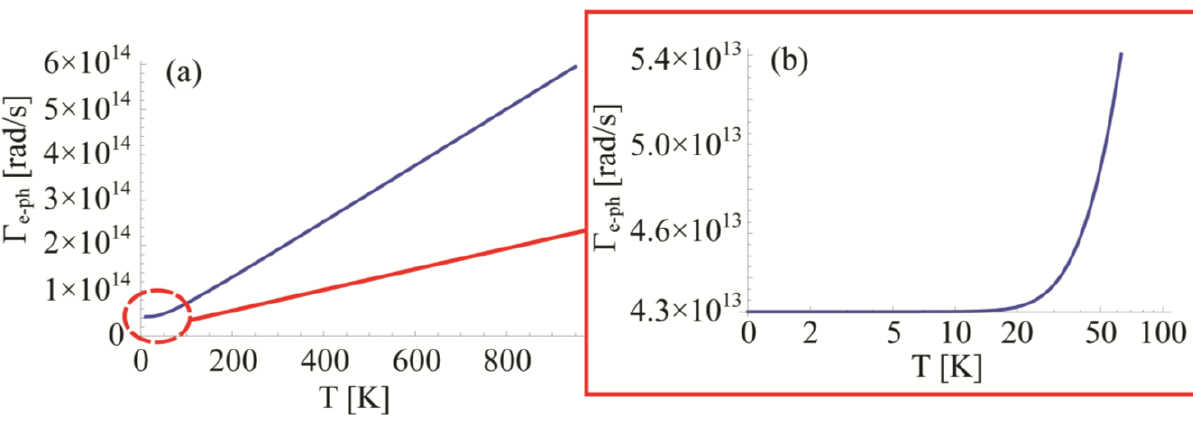
Figure 9. ( a ) Electron-phonon scattering dependence on temperature up to 1000 K and ( b ) zoom at low temperature. Au is